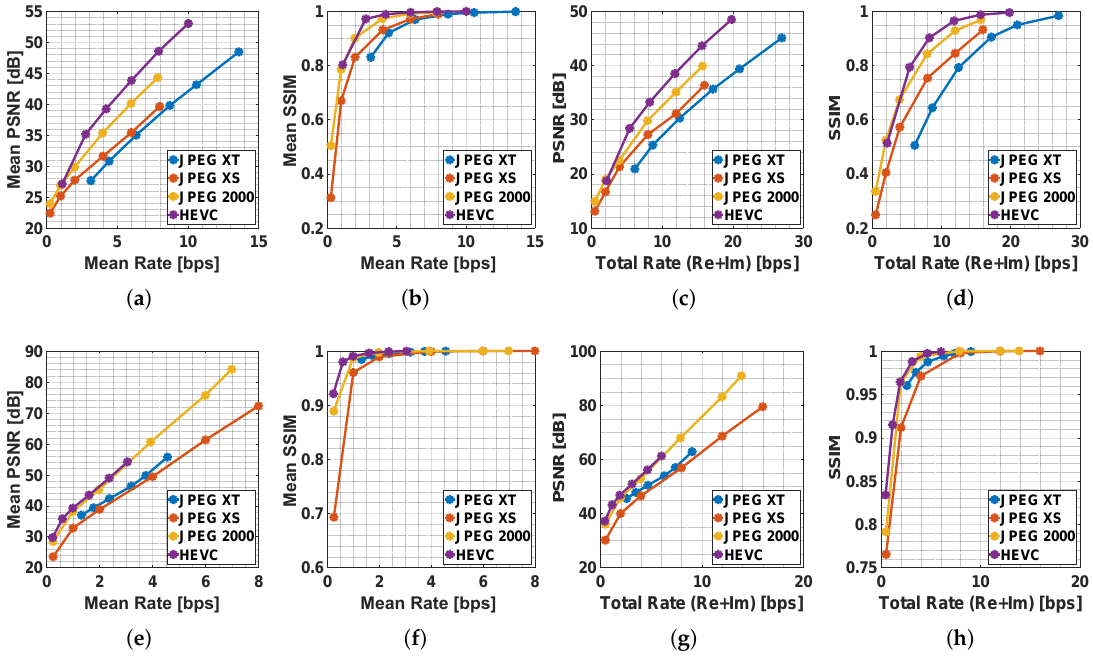
Figure 5. Dices 8K ( a – d ) and Skull ( e – h ) compression results: mean PSNR ( a , e ) and mean SSIM ( b , f ) in the hologram domain vs. bps (bits per sample); PSNR ( c , g ) and SSIM ( d , h ) in the reconstructed domain vs.